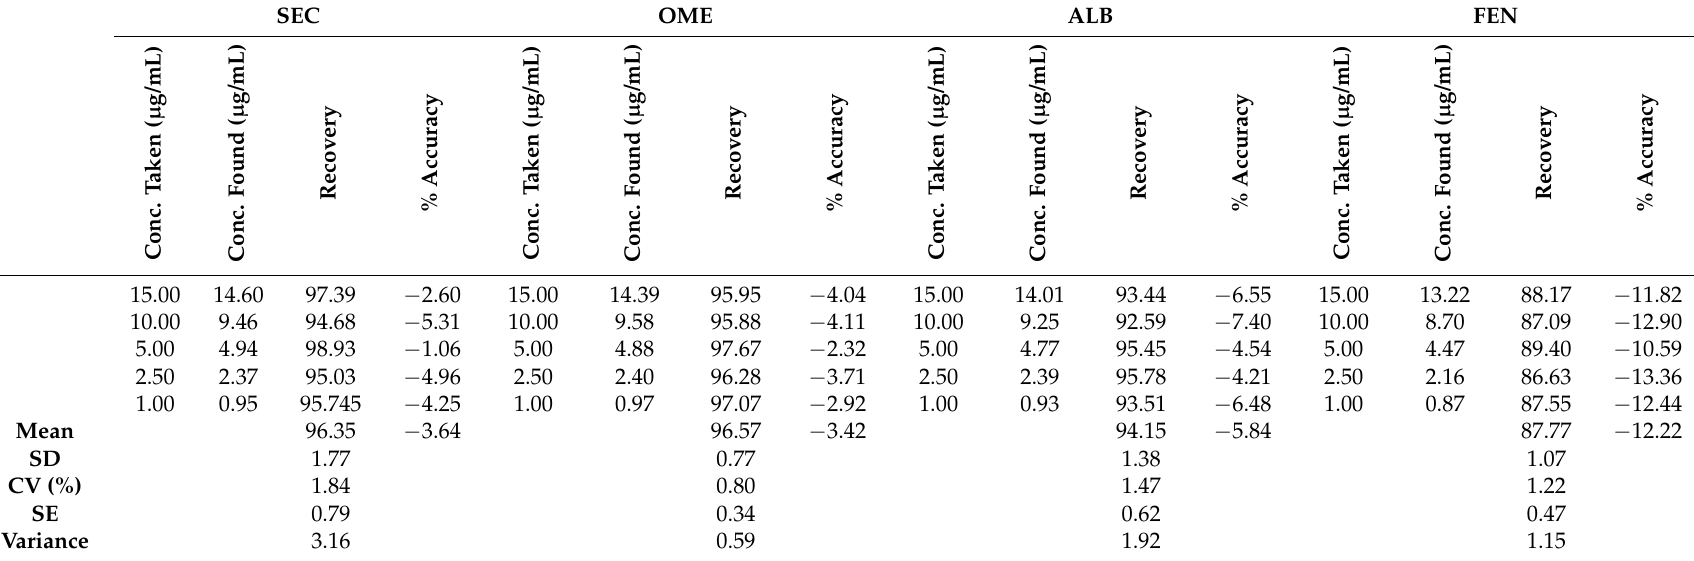
Table 8. Result of analysis of proposed method in human